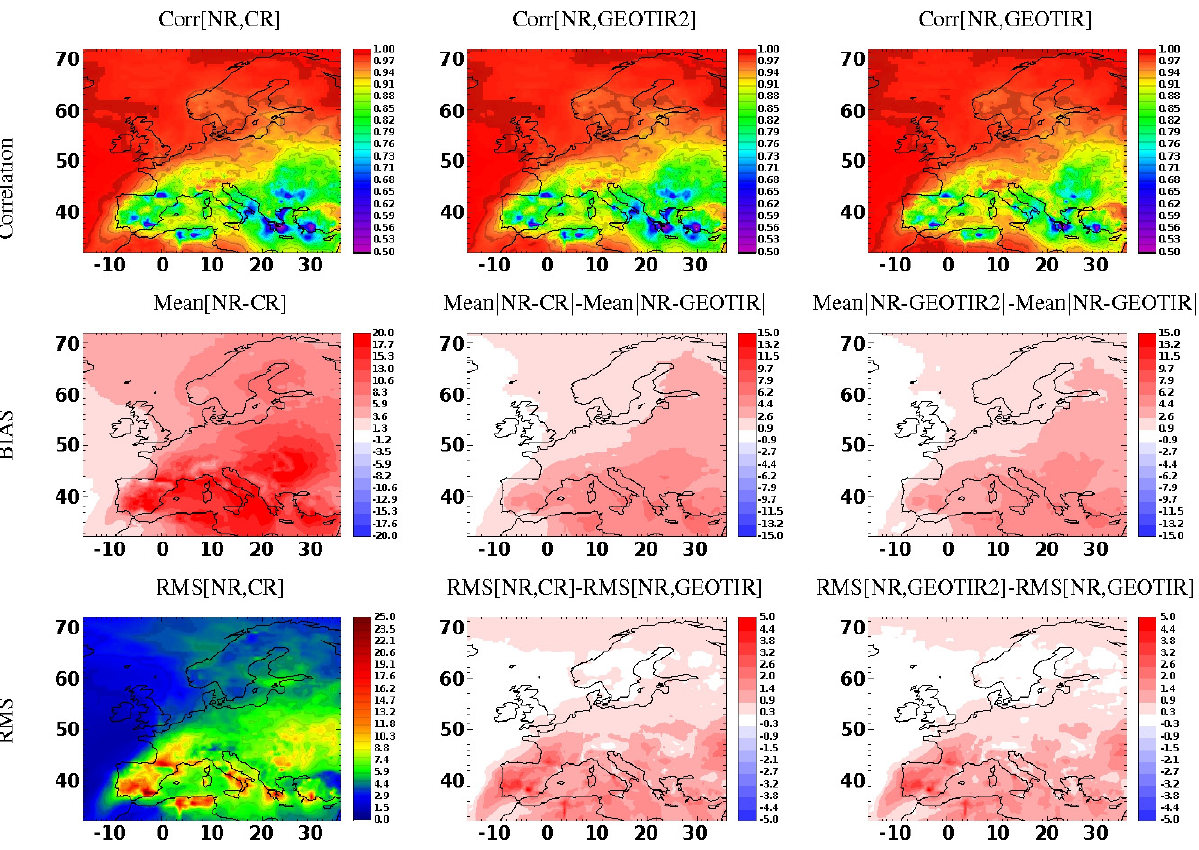
Fig. 7. Same as Fig. 5 but for the experiment with a change in the emissions